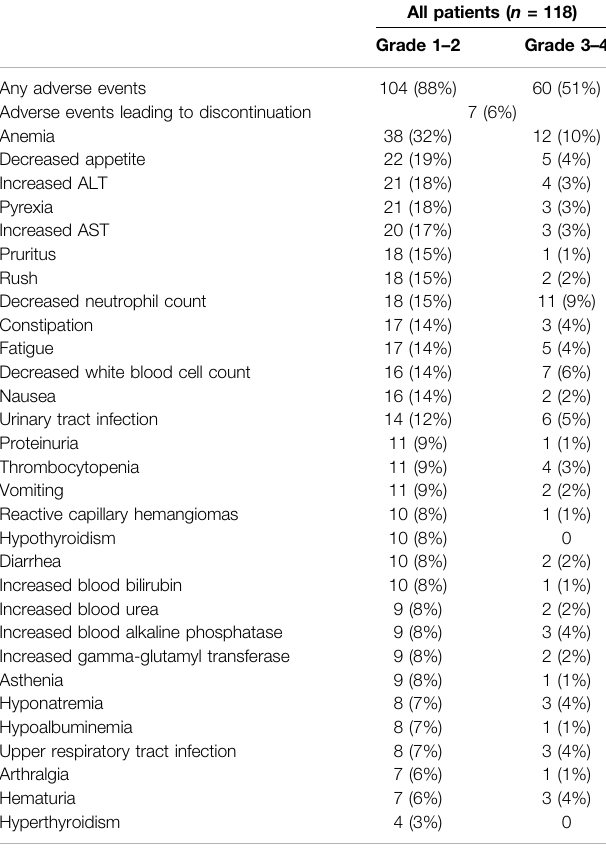
TABLE 2 | Treatment-related adverse events occurring in patients.